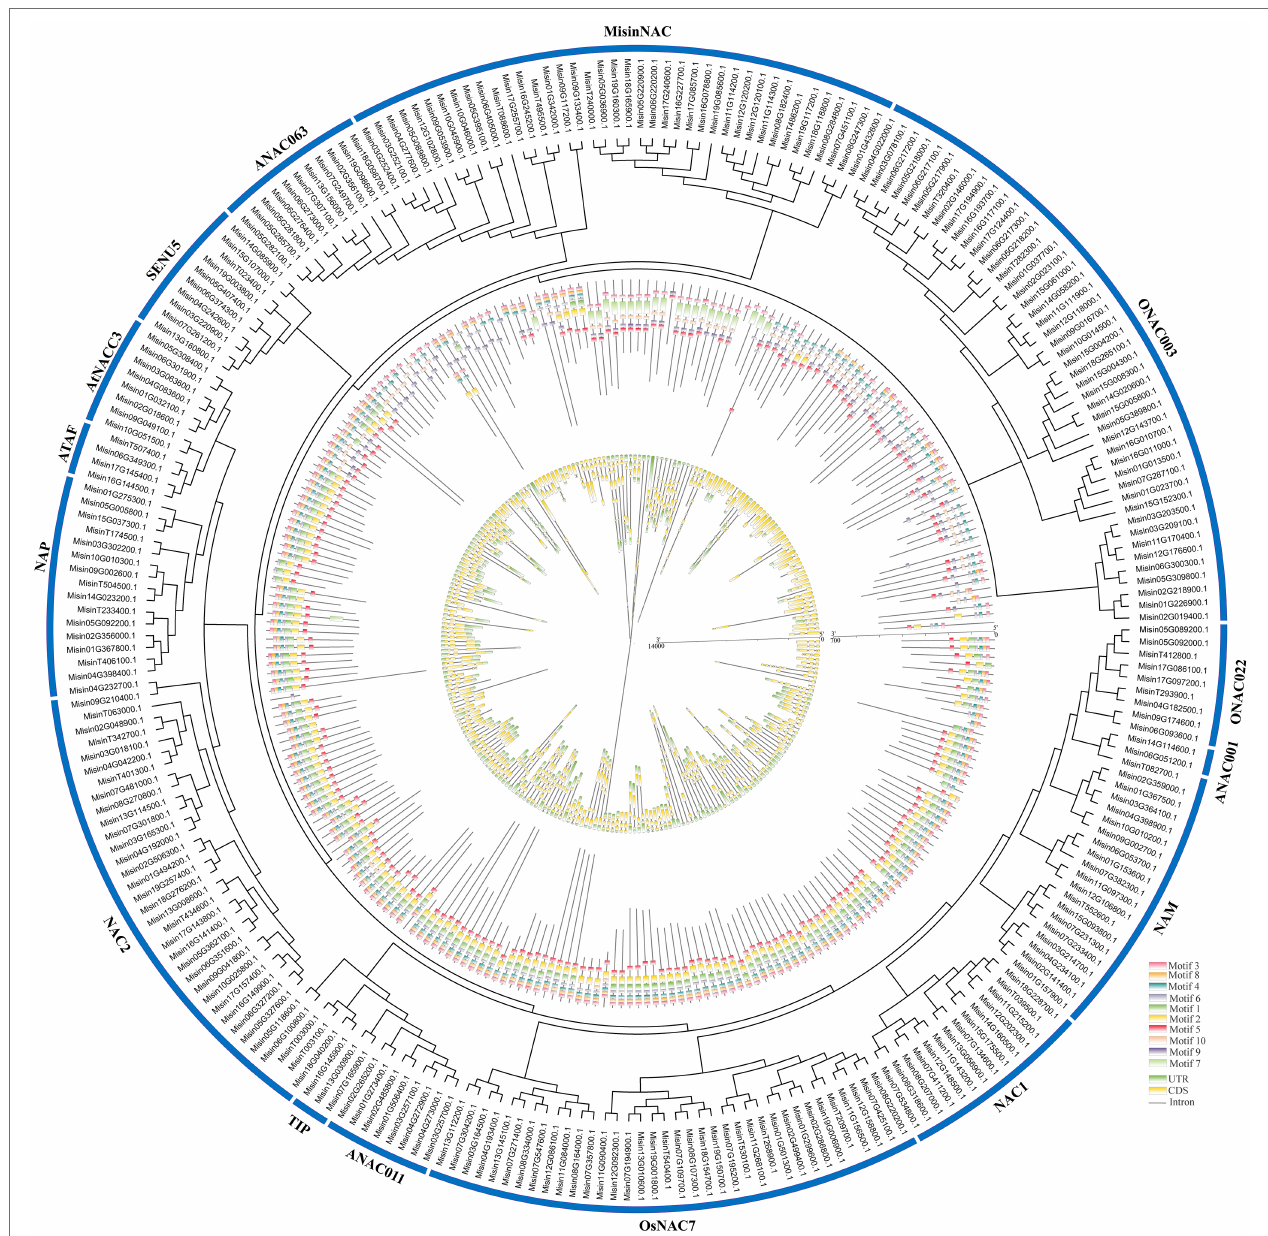
FIGURE 2 | Phylogenetic relationships, motifs pattern, and gene structure of NAC genes from M. sinensis . The unrooted phylogenetic tree was constructed based on the full-length sequences of NAC proteins. The motifs composition of the NAC proteins was identified by MEME, and grey lines represent the non-conserved sequences. Each motif is indicated by a colored box numbered at the bottom, and the sequence information for each motif is provided in Supplementary Figure S1 . The exon-intron structure of NAC genes was performed by using the online tool GSDS. Lengths of exons and introns of each M. sinensis NAC gene were exhibited